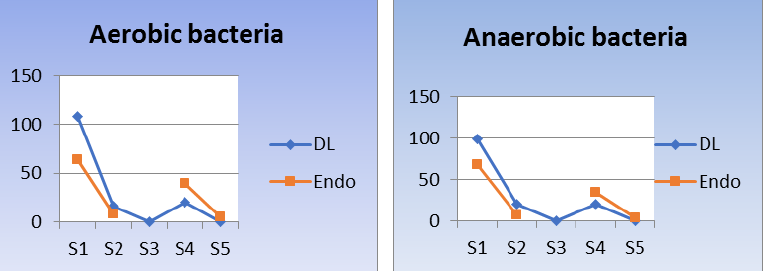
Figure 3. Line chart showing bacterial count ( a ) aerobic and ( b ) anaerobic. Means with different small letters in the same column indicate statistically significance difference, means with different capital letters in the same row indicate statistically significance difference. *; significant (p<0.05), ns; non-significant (p>0.05).